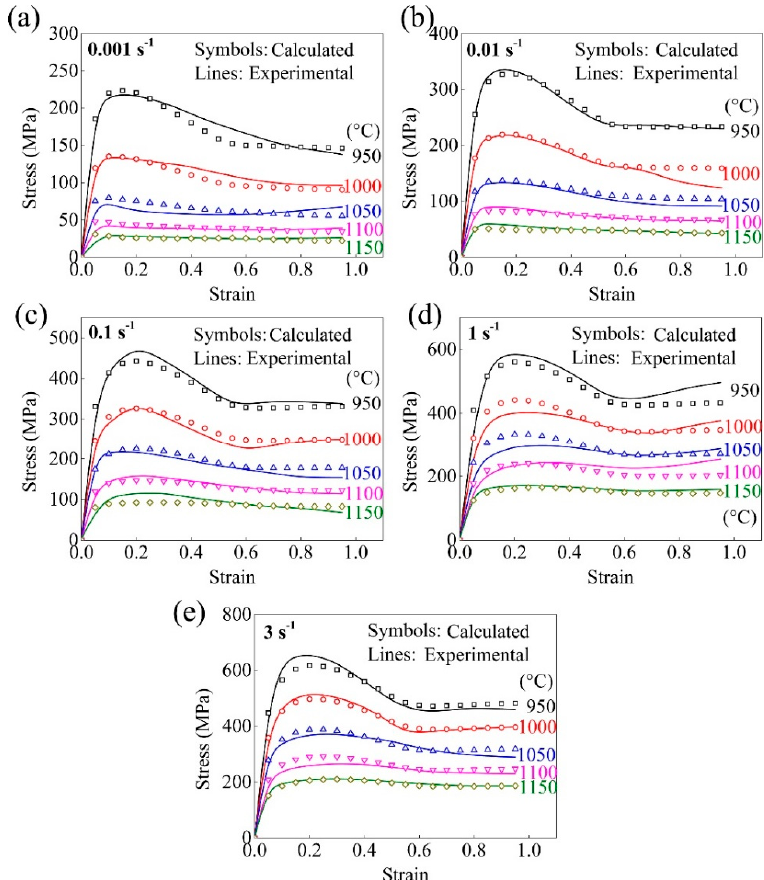
Figure 5. Comparisons of the calculated and experimental flow stress at the strain rates of ( a ) 0.001 s − 1 ,